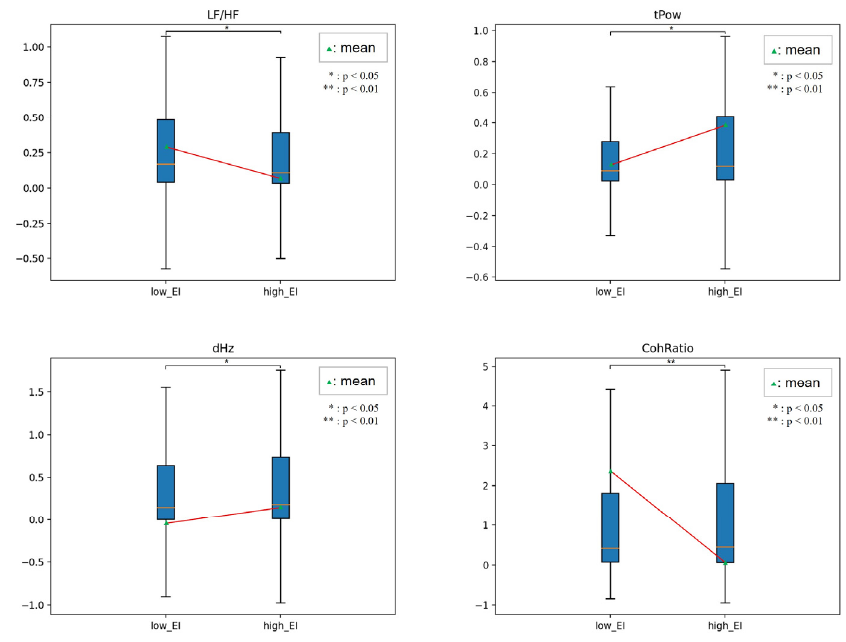
Figure 13. Comparison between low and high EI in inertia.